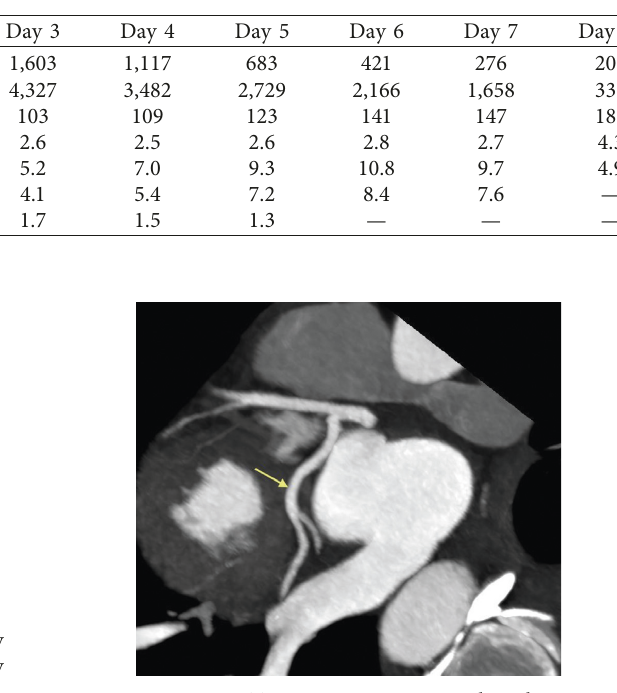
Table 2: Trend of liver function tests.